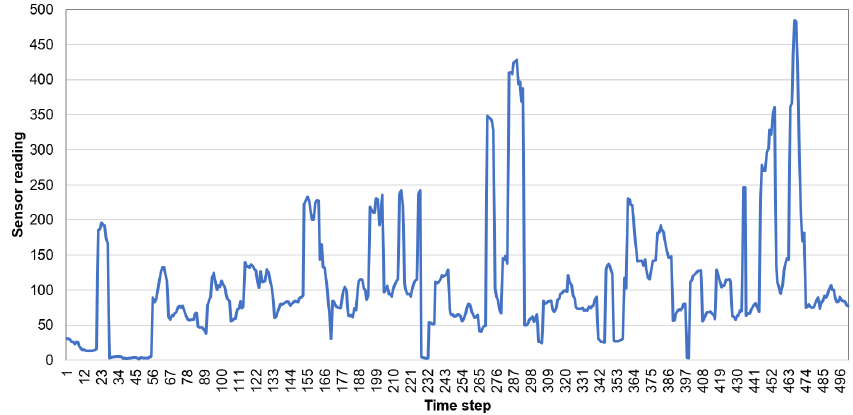
Figure 13. Readings of light sensors collected during walk (mean value for time window). Prediction results for the data readings of light sensor are presented by the scatter plots in Figures 14 and 15. These results clearly show that the naive prediction (Figure 14) is more accurate than the neural network (Figure 15) as the data points in scatter plot for naive prediction are more closely concentrated along the diagonal line.